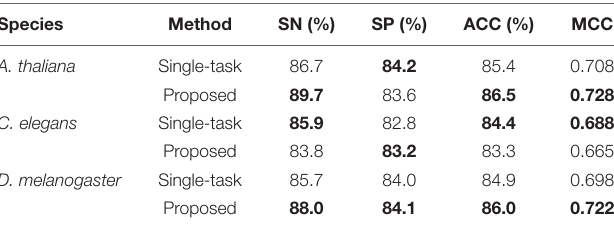
TABLE 3 | Performance comparison with the model not using the multi-task learning. Species